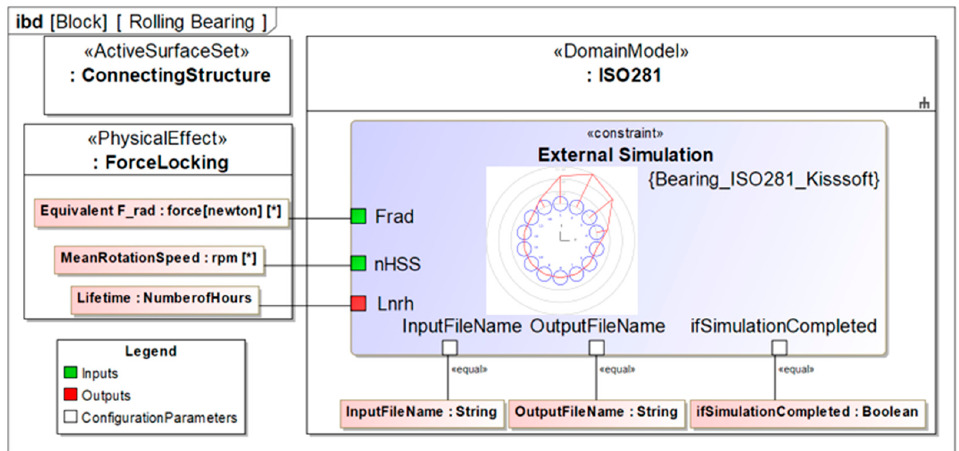
Figure 8. The fatigue analysis of a WT bearing system in the internal block diagram .